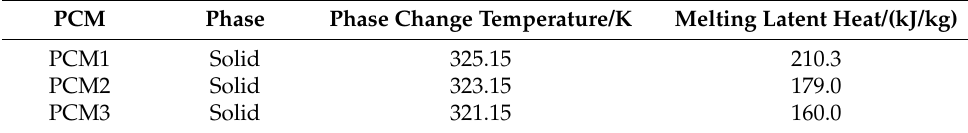
Table 2. Phase change temperature and melting latent heat of the phase change materials.